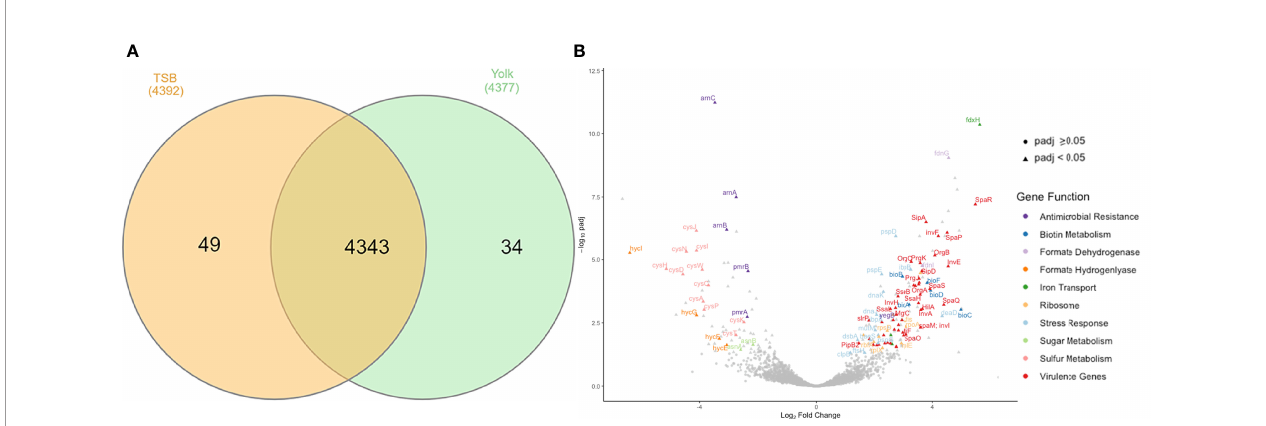
FIGURE 3 | Genes transcribed by Salmonella Enteritidis, grown in tryptic soy broth or egg yolk, as revealed by RNA sequencing. (A) Summary of transcribed genes; (B) Volcano plot of differential expression results for all genes analyzed by RNA sequencing, emphasizing important differentially expressed